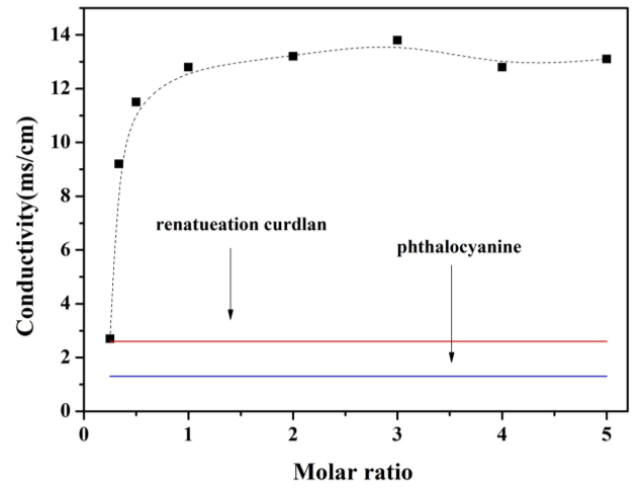
Figure 7. Conductivity of the samples.